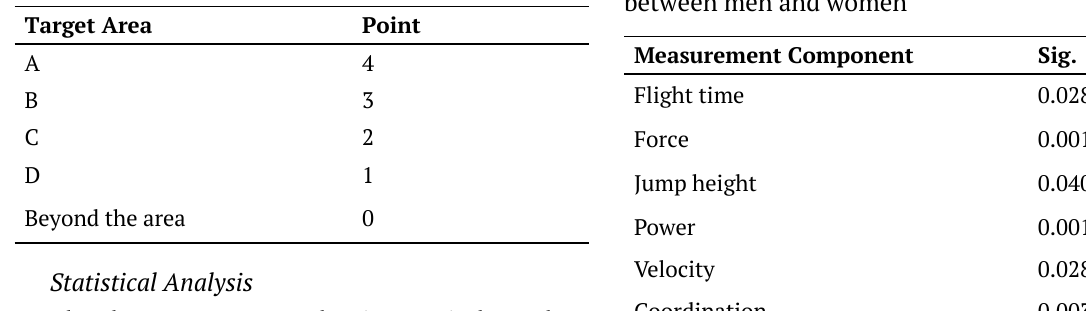
Table 2. Scoring system for Spike Skills Test Table 3. Comparison of measurement component